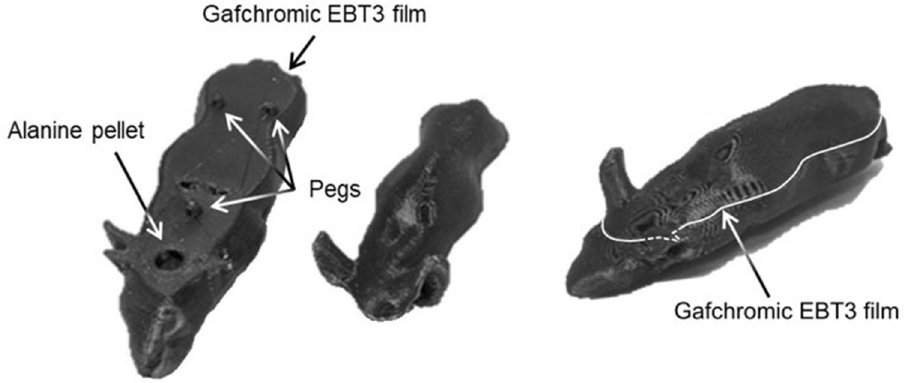
Figure 1. The 3D printed murine dosimetry phantom. An Ultimaker 3 fused deposition modelling printer was used to create bespoke phantoms capable of securing Gafchromic EBT3 film over an alanine pellet to capture an absolute dose measurement and dose distribution with reference to a national primary standard. The assembled phantom is shown on the right. A second version of the same phantom was printed with the alanine pellet cavity situated in the pelvis